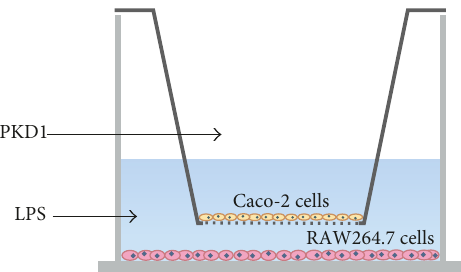
Figure 1: Schematic illustration of the co-culture system. Protein kinase D1 (PKD1) was administered to Caco-2 cells grown for 21 daysintranswellinserts,whilelipopolysaccharide(LPS)wasadmin- istered to RAW264.7 macrophage cells to induce an inflammatory